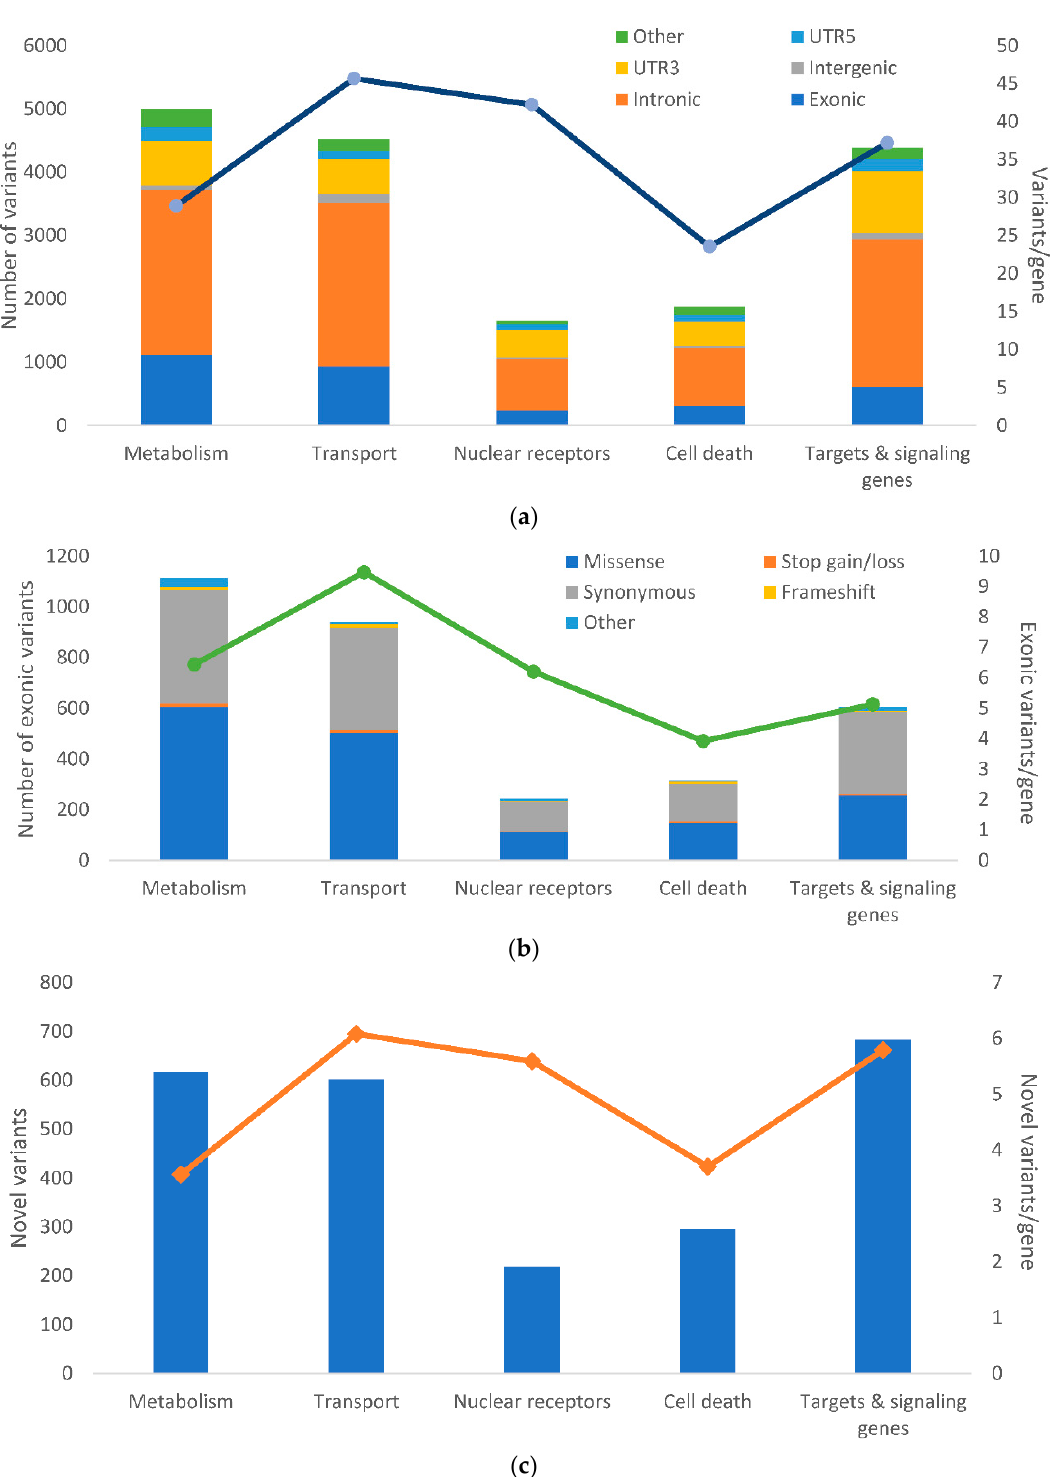
Figure 2. Distribution of alterations in the studied groups of genes. The picture shows: ( a ) the frequency of genetic alterations according to their functional classes; ( b ) The frequency of genetic alterations according to their exonic functional classes analyzed by RefSeq: NCBI Reference Sequence Database (https://www.ncbi.nlm.nih.gov/refseq/) shown according to the groups of studied genes; ( c ) The number of novel variants according to the groups of genes. The number of the variants normalized to the counts of genes per each group are shown for each plot on the right axis and depicted by the overlaid line. Column plots for all gene groups are shown in Figure S2.